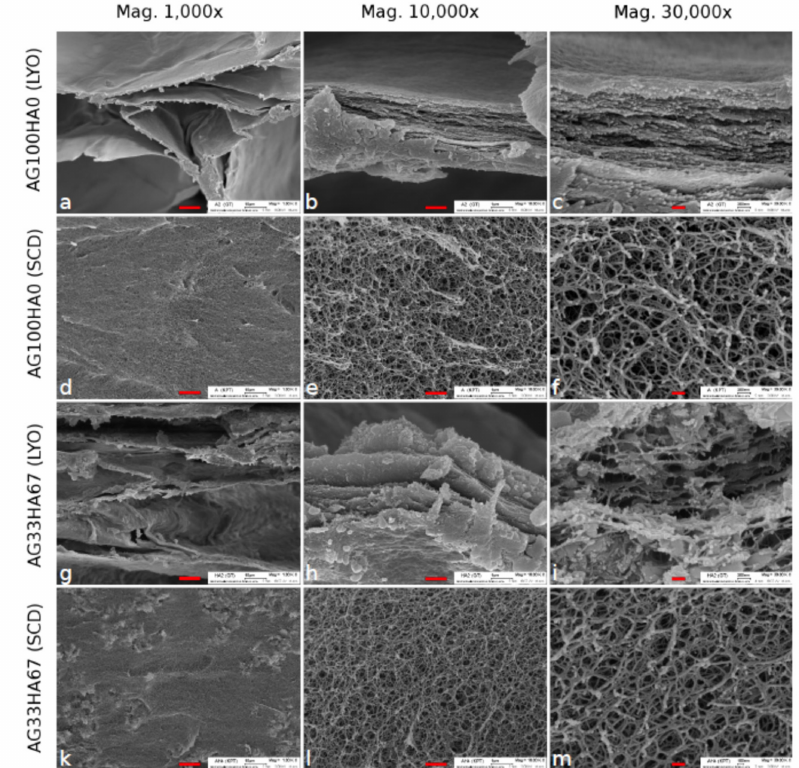
Figure 3. SEM images of agarose lyophilized (LYO) ( a – c ) and supercritically-dried (SCD) ( d – f ) and agarose / hydroxyapatite(33 / 76w%)compositeLYO( g – i )andSCD( k – m )atthreedi ff erentmagnifications. The scale bars are 10 µ m (left), 1 µ m (middle), and 0.2 µ m (right), respectively. Reproduced